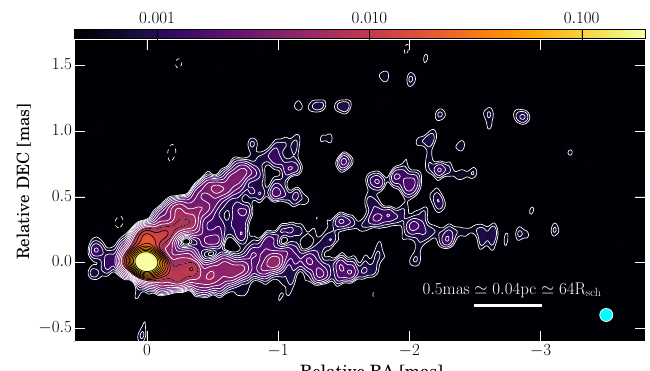
Figure 2. High-resolution image of M87 jet at 3 mm obtained by stacking the five VLBI maps convolved with a common circular beam of 0.1 0.1 mas shown as the cyan-colored circle at the right bottom corner. × The colorbar indicates Stokes I intensity in units of Jy/beam. The peak intensity is 522 mJy/beam and the off-source rms noise level is 0.12 mJy/beam, resulting in a dynamic range of around 4300. Lowest contour level is 0.5 mJy/beam and the contour lines increase by a factor of √ 2.